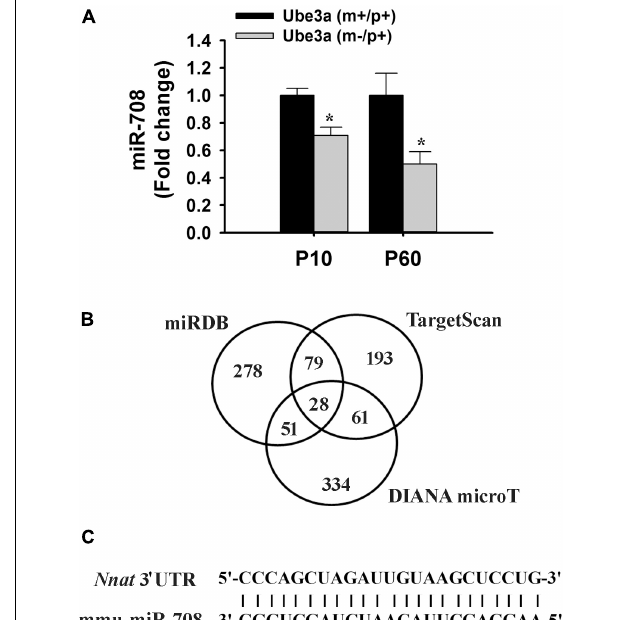
FIGURE 1 | Down-regulation of miR-708 in AS mice brain and identification of Nnat as one of its predicted target. (A) Quantitative RT-PCR analysis of miR-708 from the total RNA extracted from the cortex sample of wild type and AS mice at postnatal day 10 and 60 (P10 and P60). Each sample was tested in triplicate and normalized against RNU6 (internal control). Values are mean ± SD with four animals/group at P10 and six animals/group at P60. ∗ P < 0.001 as compared to respective wild type group. (B) Venn diagram depicting the number of identified target gene predicted by three different algorithms. (C) Sequence of miR-708 and the probable binding site at the 3 (cid:48) -UTR of Nnat that shows 100% resemblance.